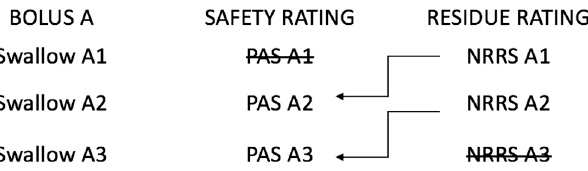
Figure 1. Schematic illustrating a hypothetical three swallow sequence of a single bolus (Bolus A), where the safety ratings from current swallows are analyzed along with residue ratings from previous swallows. PAS: Penetration–Aspiration Scale; NRRS: Normalized Residue Ratio Scale. Schematic is adapted with permission from: Molfenter SM, Steele CM. The Relationship Between Residue and Aspiration on the Subsequent Swallow: An Application of the Normalized Residue Ratio Scale.